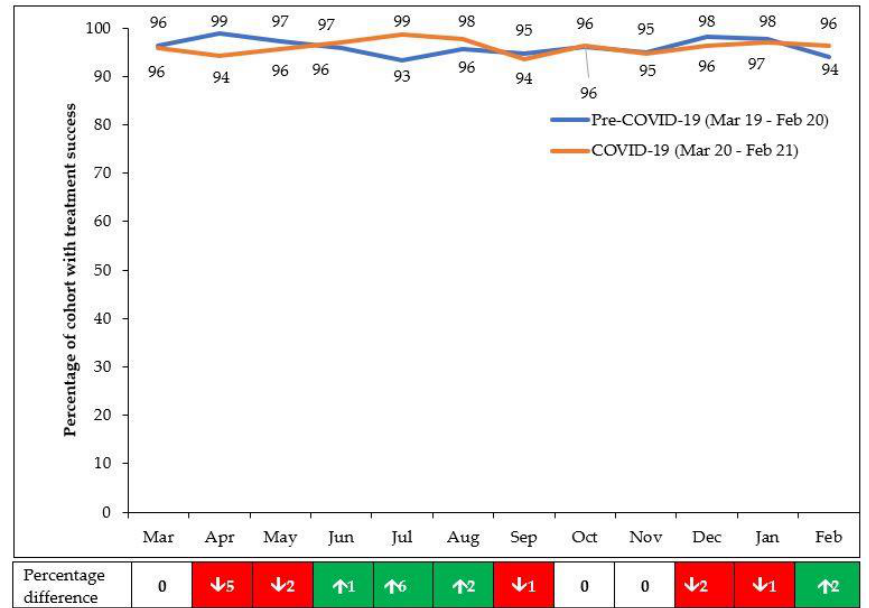
Figure 4. Treatment success amongst those enrolled each month in eight health facilities in Lilongwe, Malawi, during pre-COVID-19 and COVID-19 periods. Enrolment occurred 8 months prior to the month of reporting (to allow for 6-months treatment and 2-months to follow-up and record the final outcome).